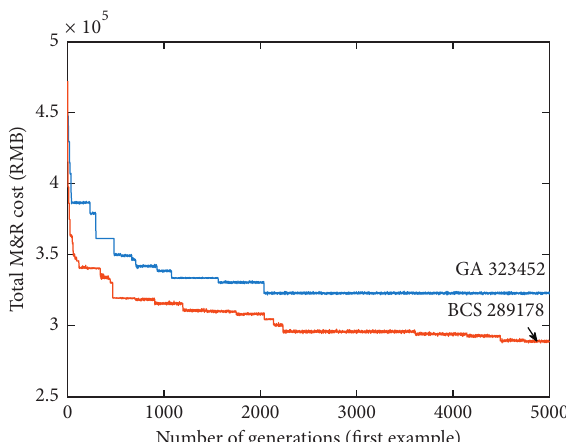
Figure 5: Convergence curve of total cost minimization.